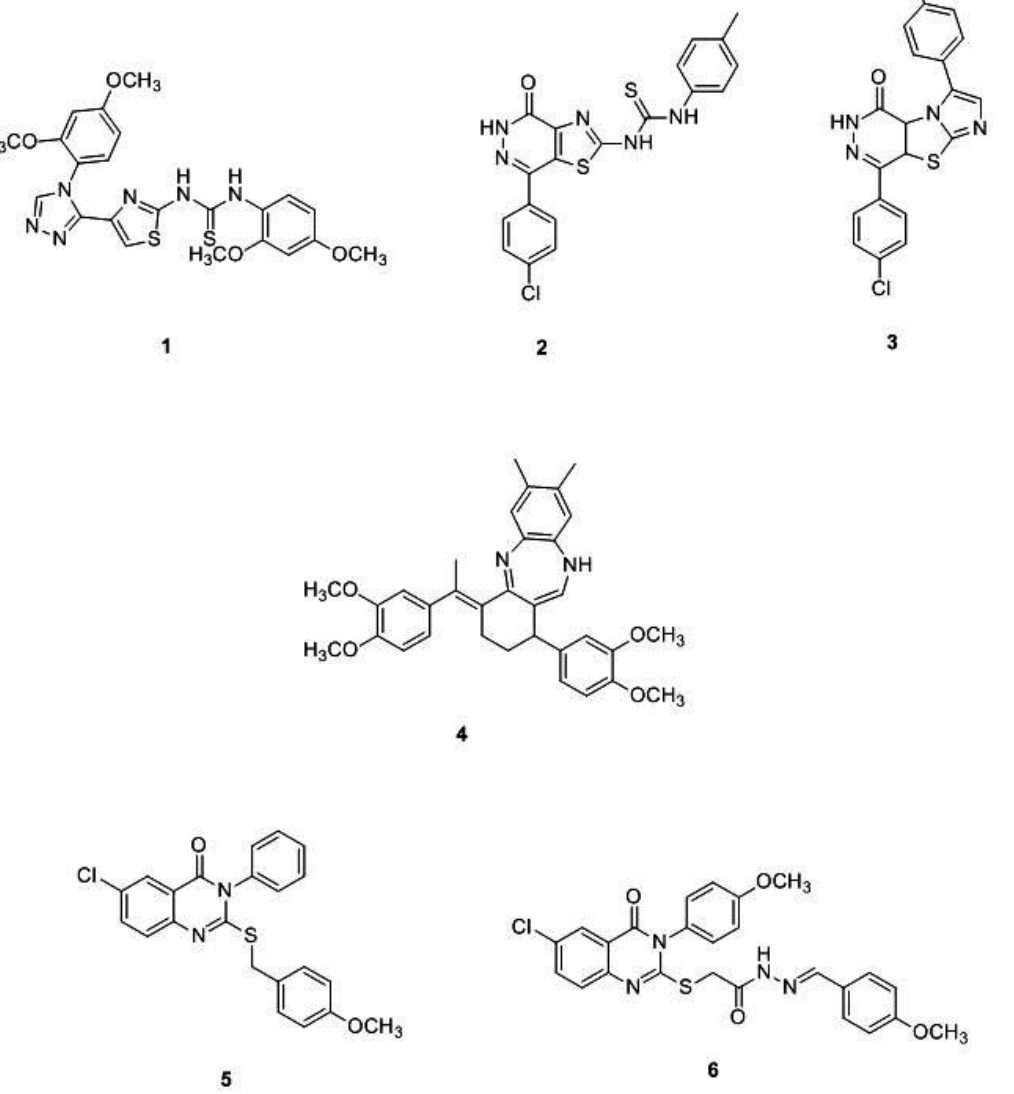
Figure 5. Chemical structures of some prominent bDHFR inhibitors.